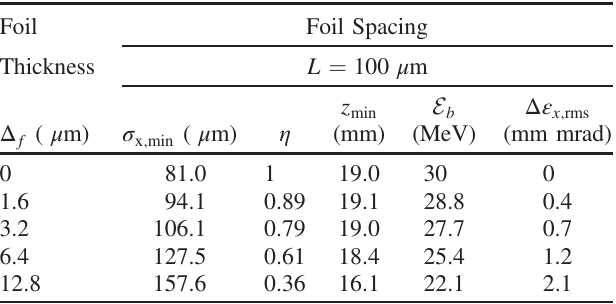
TABLE I. Minimum σ and corresponding z -location z x ; min min (effective focal length) for foil spacing L ¼ 100 μ m and initial ¼ 30 MeV for different foil thicknesses Δ kinetic energy E . b f Corresponding focusing efficiency η , kinetic energy E at σ , b x ; min and beam rms emittance growth Δ ε at σ are displayed for x; rms x ; min the 30 MeV initial beam shown in Fig. 6 and